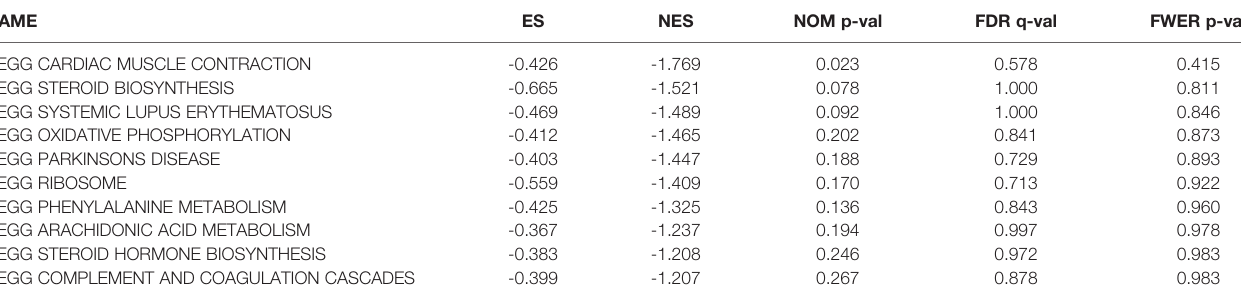
TABLE 2 | KEGG enrichment analysis (Top